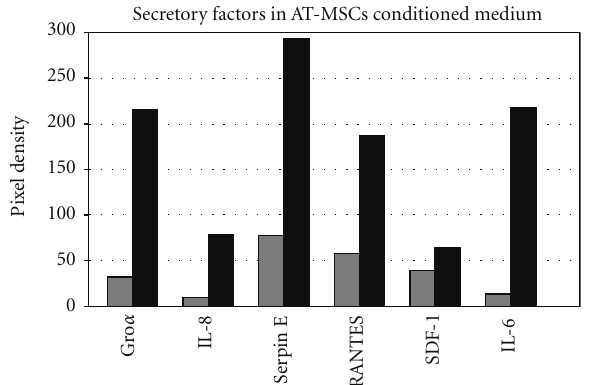
Figure 3: Cytokines and chemokines found to be present at sig- nificant levels in AT-MSCs conditioned medium (black columns) compared to control DMEM medium (grey columns). The figure represents only the cytokines and chemokines which are known to a ff ect T helper activities.